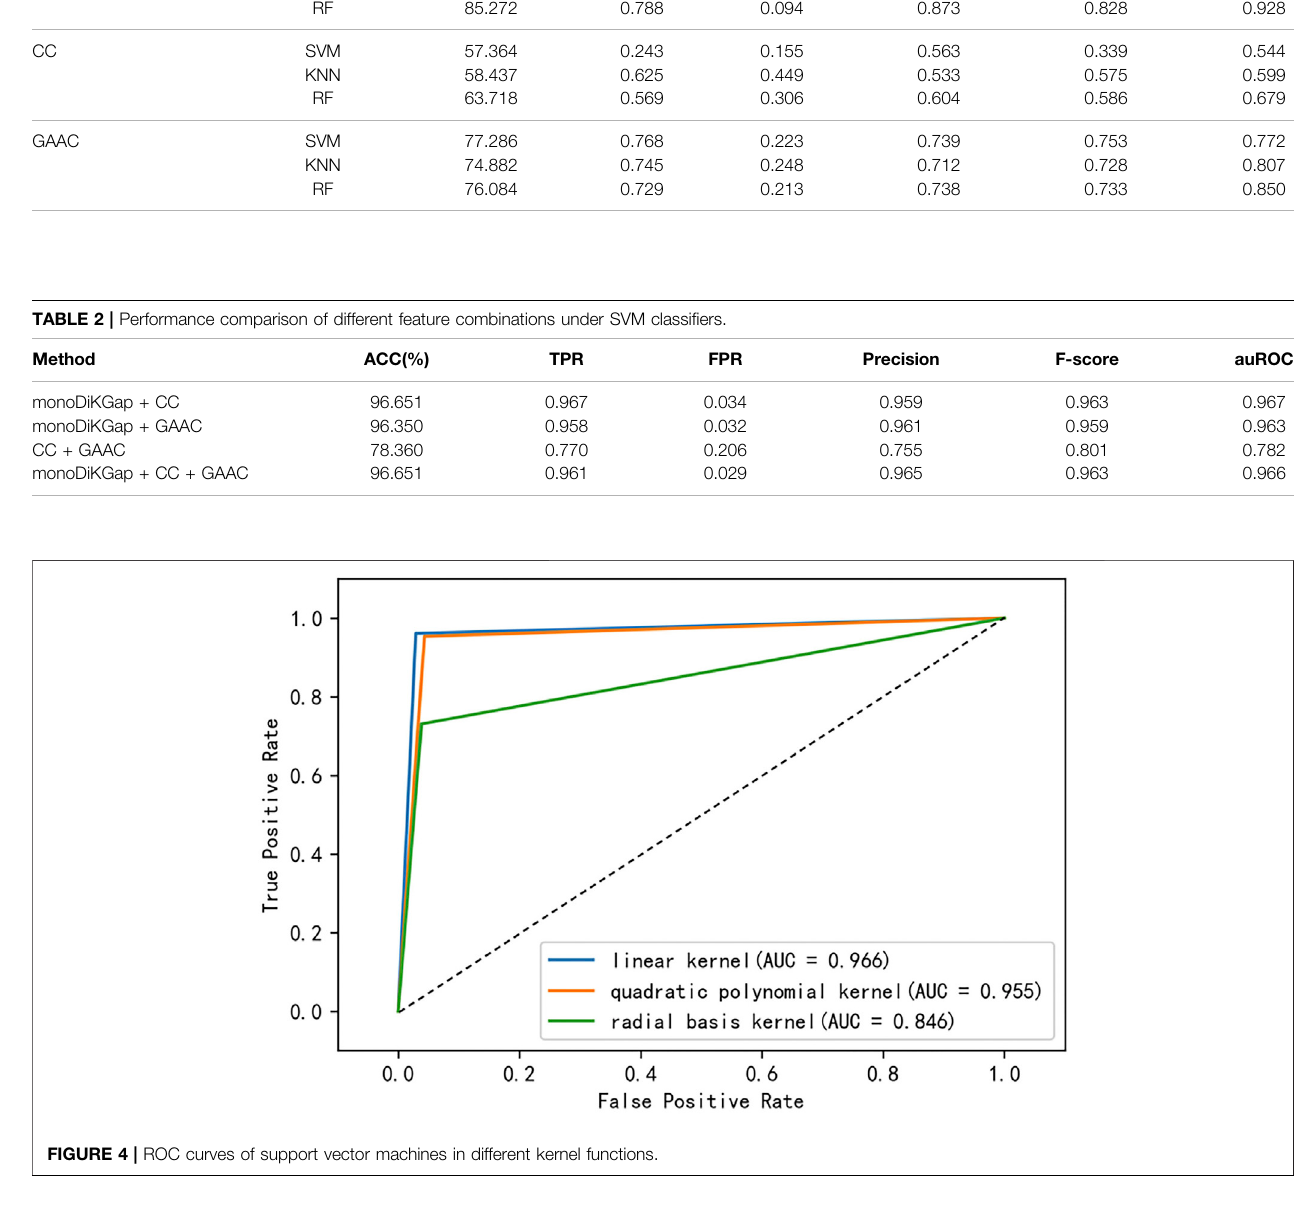
Frontiers in Pharmacology |